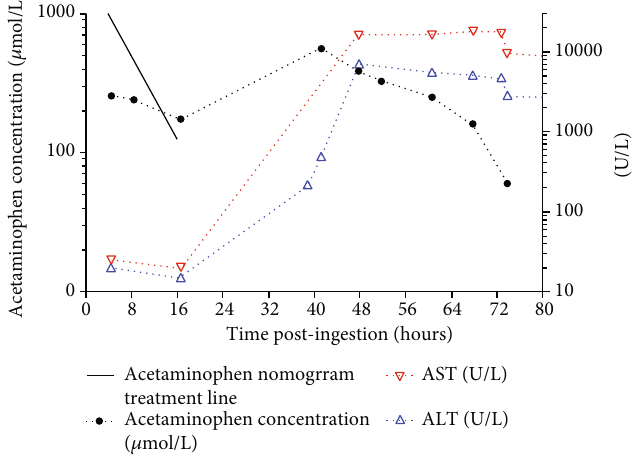
Figure 1: Acetaminophen concentrations, ALT, and AST vs. time post-ingestion. Note: 16 h acetaminophen concentration was measured retrospectively after the patient developed